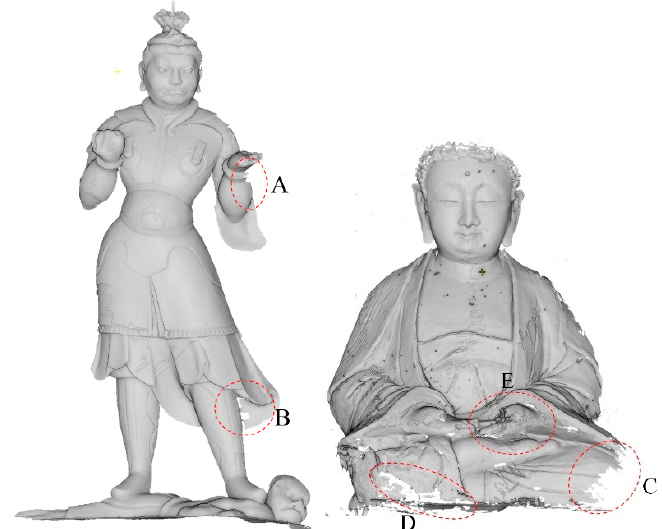
Figure 13. Inspection of General and Buddha data ( A – E ) denote the detected areas with quality issues).